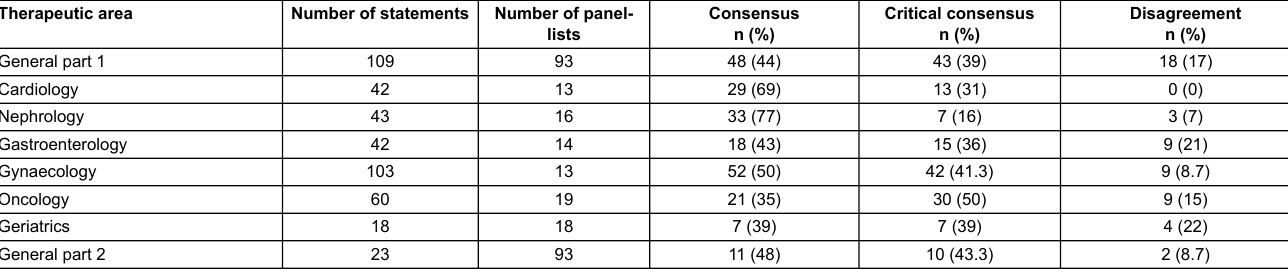
Table 2: Proportion of agreement, critical agreement and disagreement among the